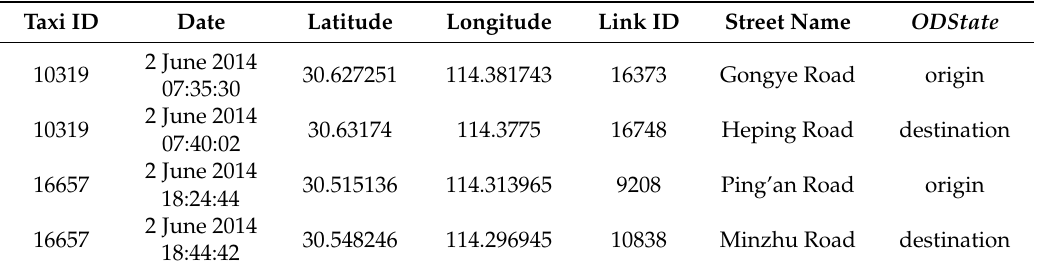
Table 3. Examples of extracted trip origins and trip destinations.